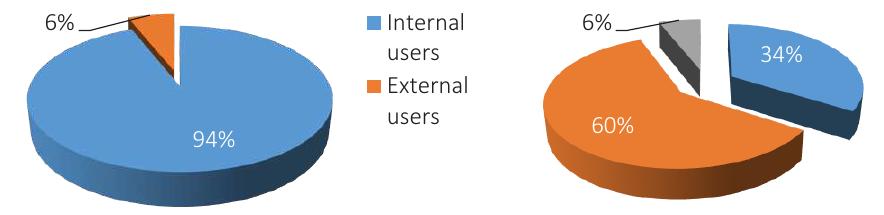
Figure 2. Information about the actors of computer